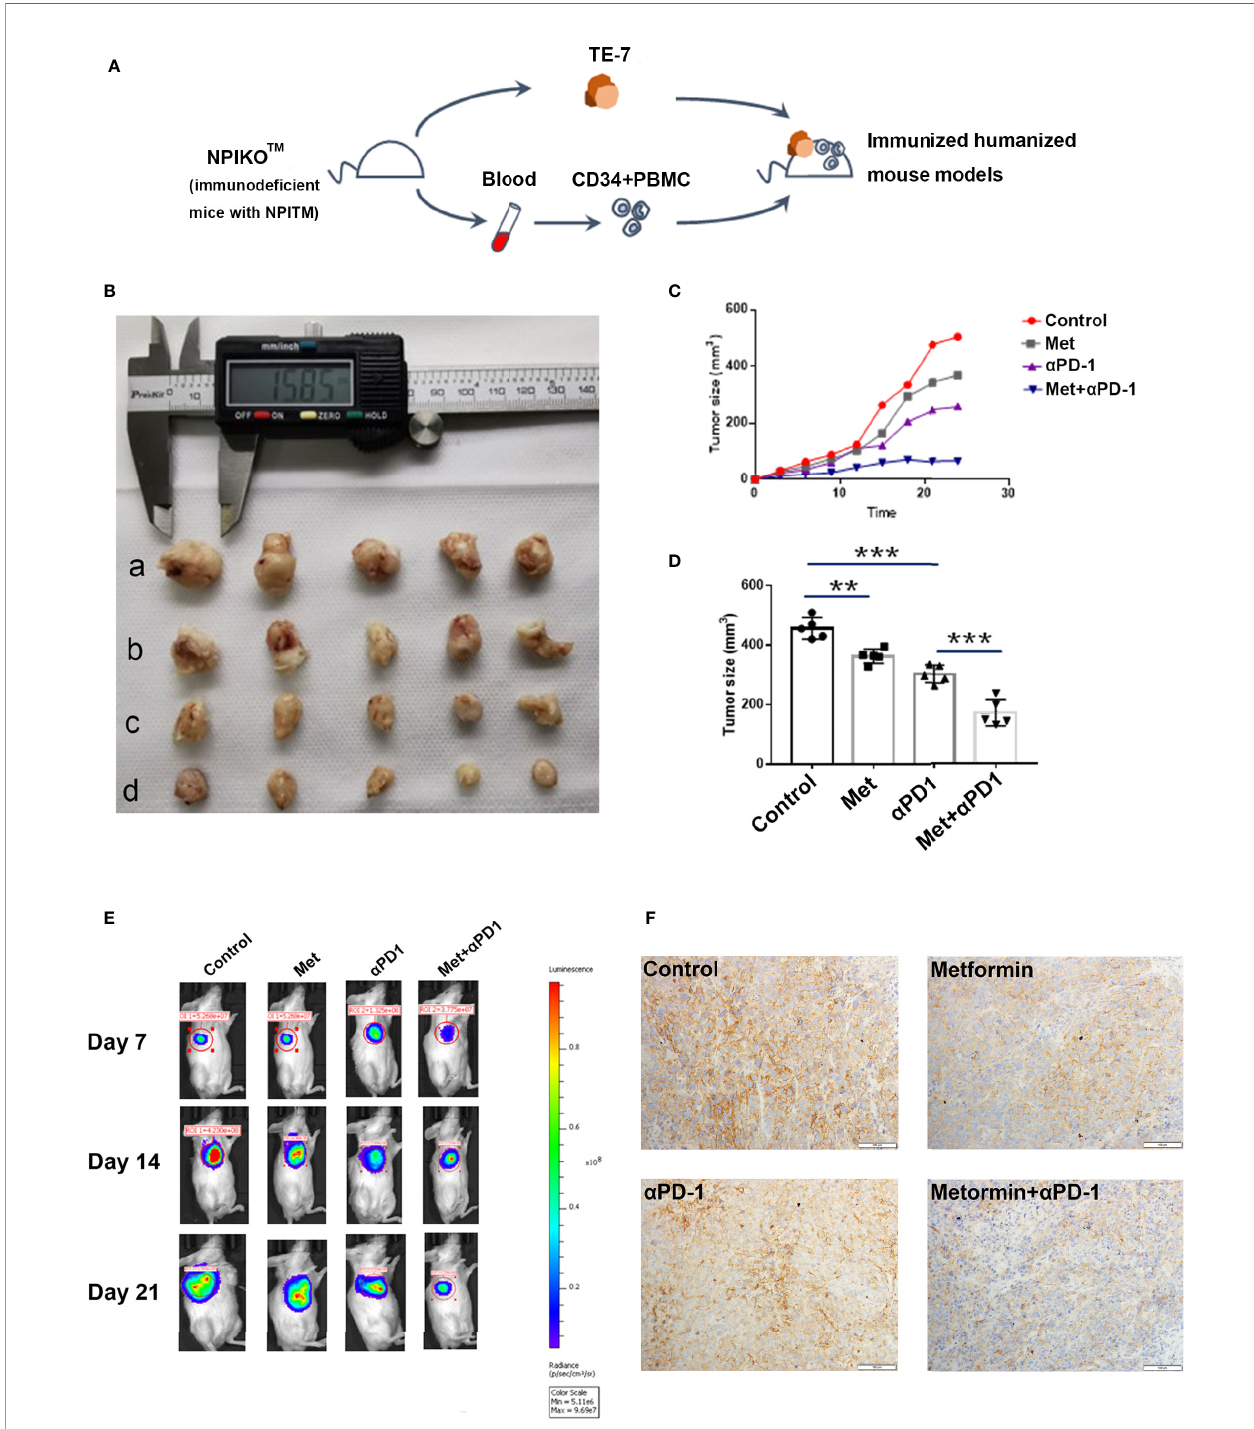
FIGURE 6 | Metformin effectively suppresses esophageal tumor growth in vivo . (A) Construction of an immunohumanized mouse model. Tumor growth of ESCC cells (TE-7) in NPI mice was injected with metformin, anti-PD1 antibody or their combination as indicated. (B) Macroscopic appearance of the tumors at 3 weeks after treatment with drugs. (C) The average tumor volumes were measured at the indicated time points (n=5 mice per group). (D) The tumor volumes at endpoint. (E) Small-animal in vivo imaging system indicating tumor growth at day 7, day 14 and day 21. (F) Immunohistochemistry showed the expression of PD-L1 in different groups. **p < 0.01, ***p <